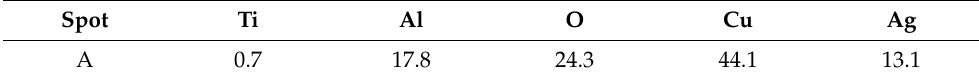
Table 2. EDS result of the spot in Figure 4 (at.